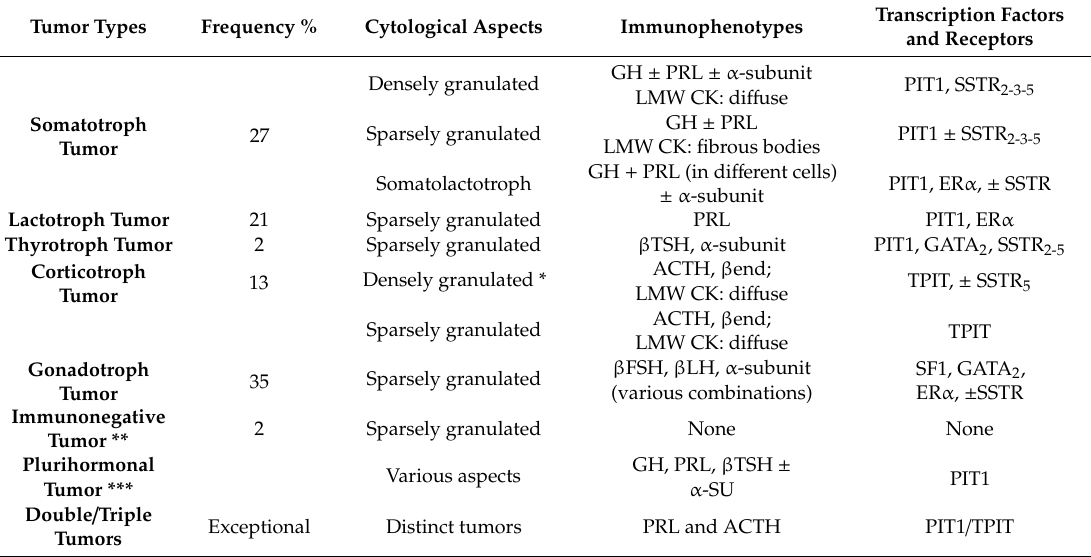
Table 3. Classification and frequency of PitNET in 2020, adapted from the WHO 2017 classification [1] and the EPPG algorithm